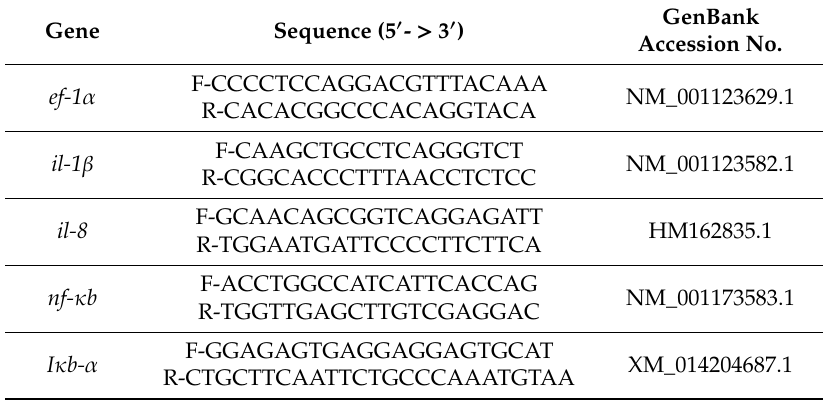
Table 1. Primers used for gene expression